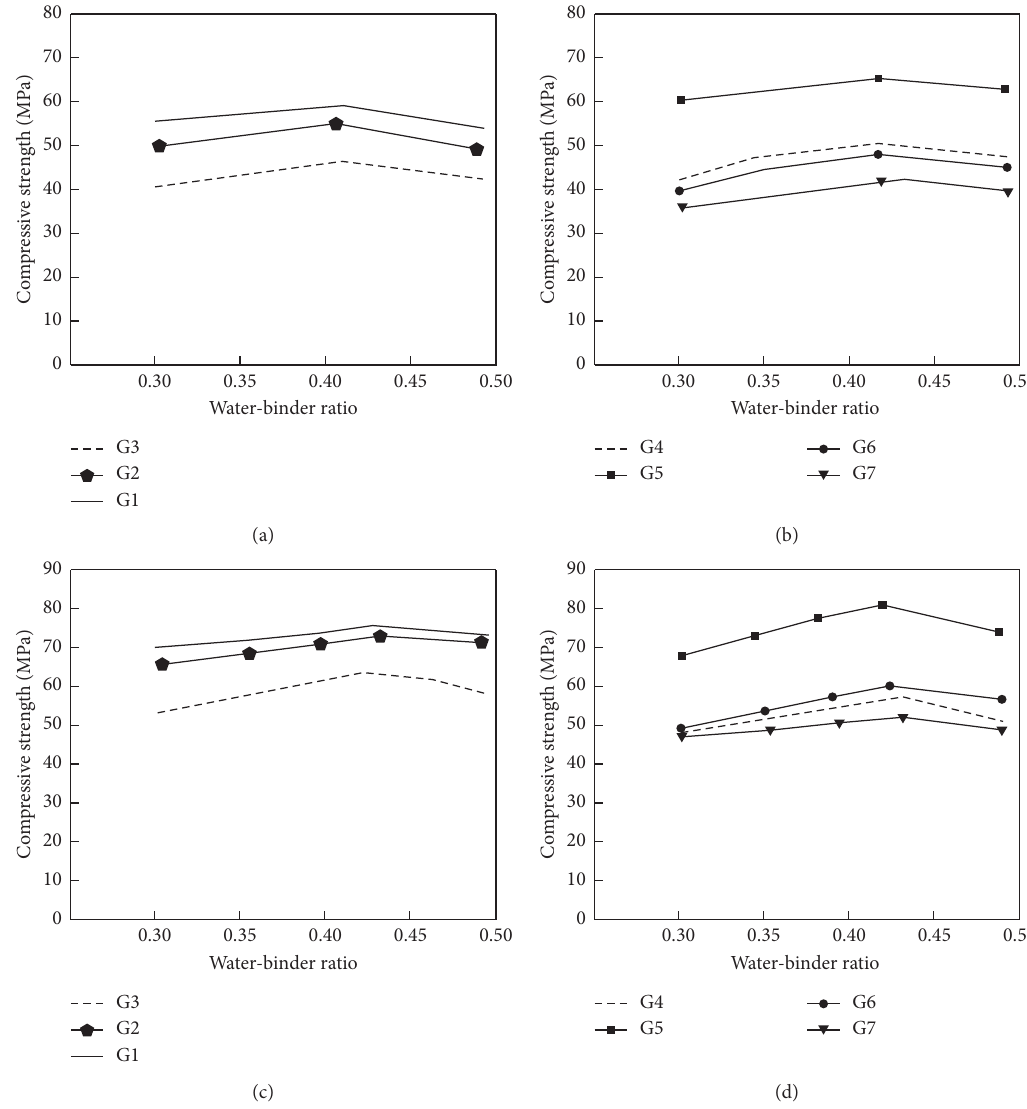
Figure 6: The variation of compressive strength of coal gangue-based polymer concrete with water-binder ratio. (a) Seven-day compressive strength (G1–G3). (b) Seven-day compressive strength (G4–G7). (c) 28-day compressive strength (G1–G3). (d) 28-day compressive strength